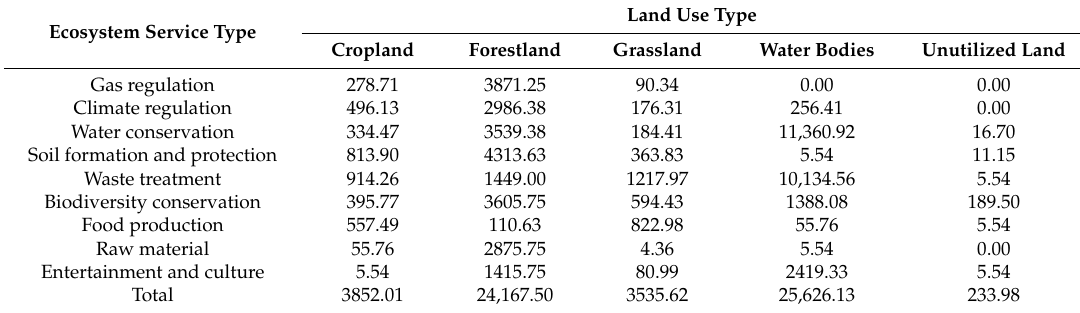
Table 1. Ecosystem service values (ESVs) of the terrestrial ecosystem (unit: Yuan RMB ha − 1 · a − 1 ). Ecosystem Service